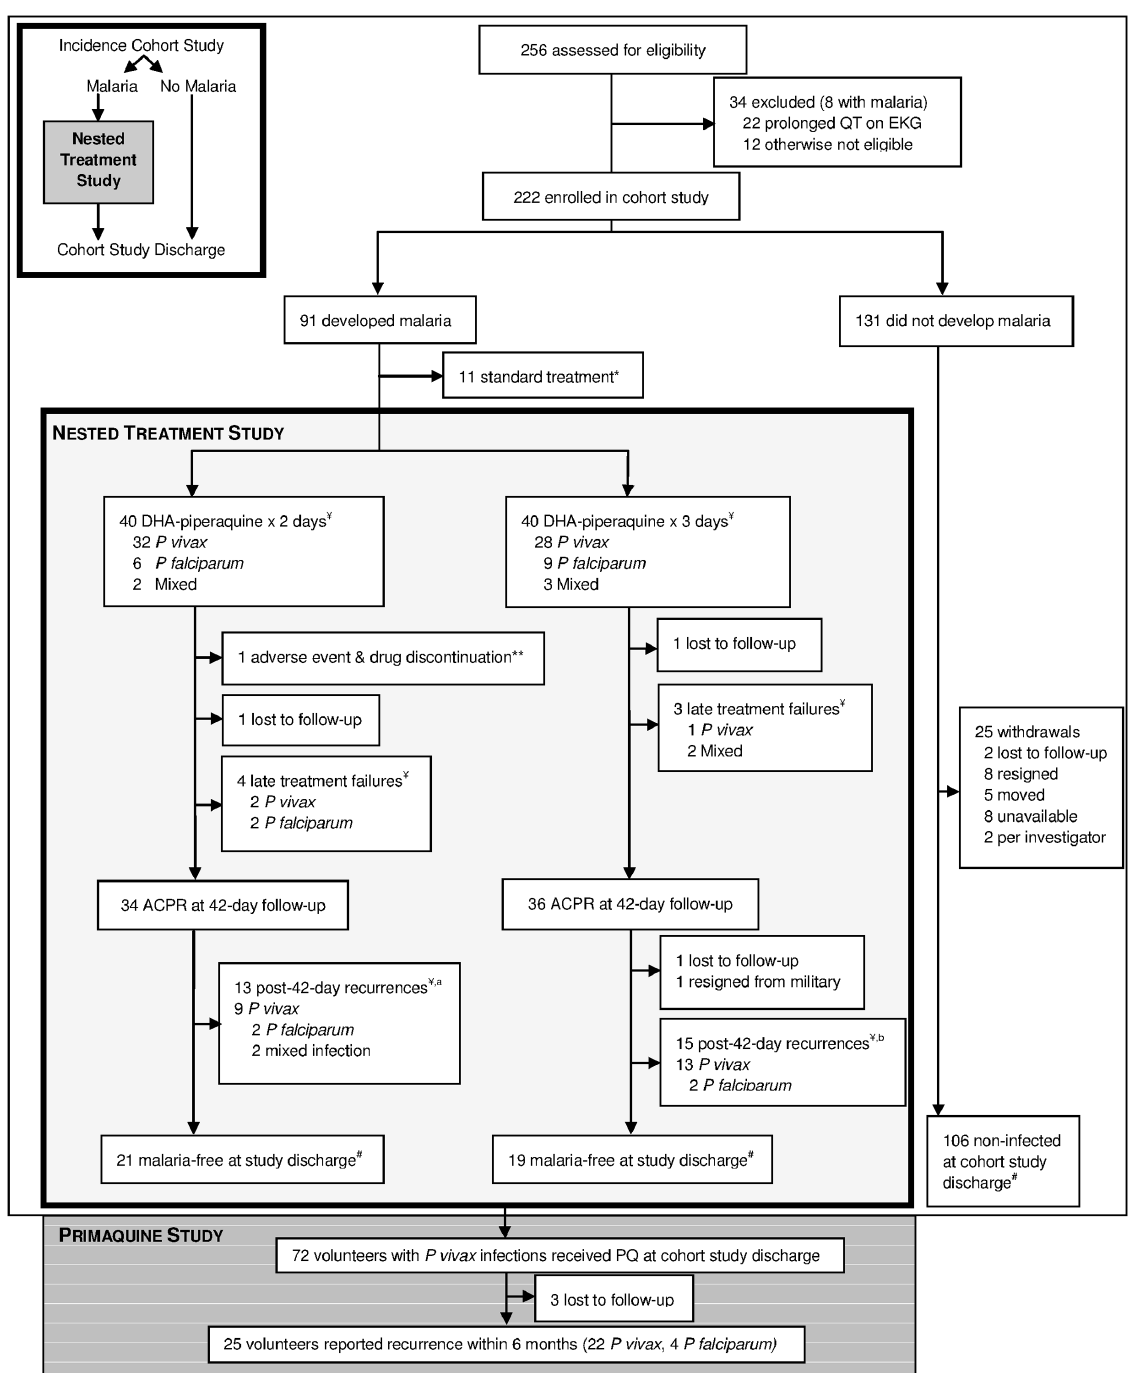
Figure 1. Study Schematic Inset and Trial Profile. *Randomization goal met, 2 withdrew. **Prolonged QTc. ¥ PCR-corrected speciation. a Not included are 2 nd recurrences (1 Pf, 1 Pv, 1 mixed). b Not included are 2nd recurrences (2 Pf, 5 Pv) and a 3 rd recurrence (1 Pv). # Study discharge varied, median 115 days follow-up.